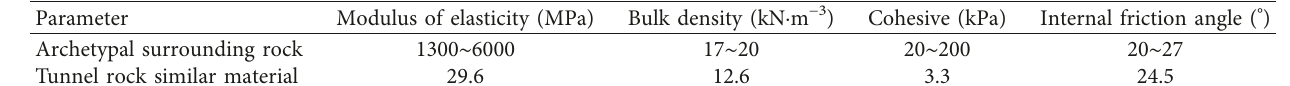
Table 4: Basic mechanical parameters of similar materials in surrounding rock.